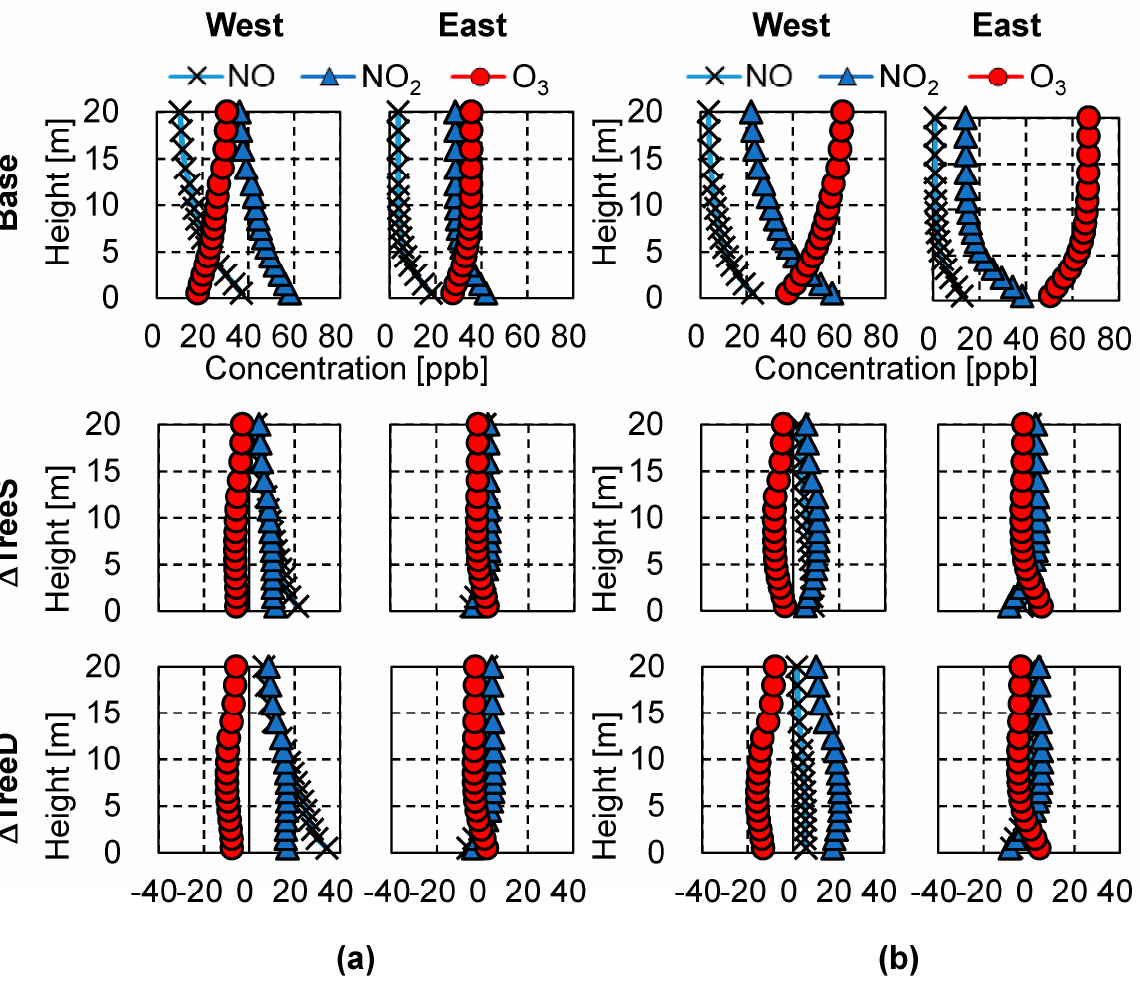
Figure 12. Vertical profiles of pollutant concentrations that were spatially averaged in the y-direction in the analysis domain at ( a ) 9:00 and ( b ) 12:00 for the Base case ( upper ), and vertical profiles of the pollutant concentration difference between the TreeS and Base cases ( middle ) and between the TreeD and Base cases ( lower ). The differences were calculated by subtracting the Base case concentration from the Tree case concentration.